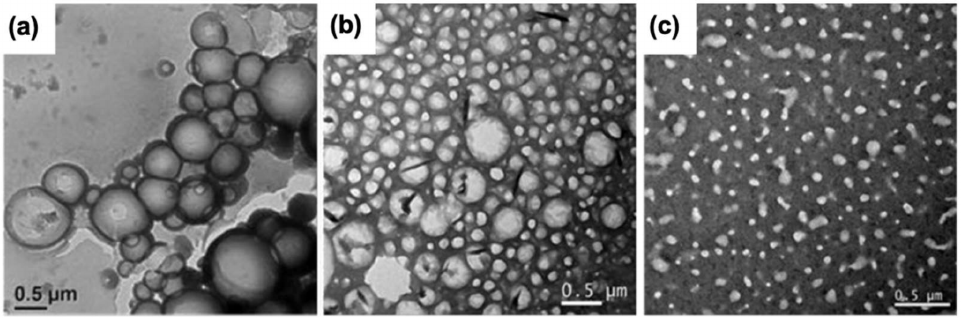
Figure 3. Transmission electron microscopy images of PDI-[F] 2 assembled in ( a ) CHCl 3 , ( b ) THF and ( c ) DMF [59]. Copyright © 2018 Wiley-VCH Verlag GmbH & Co. KGaA,